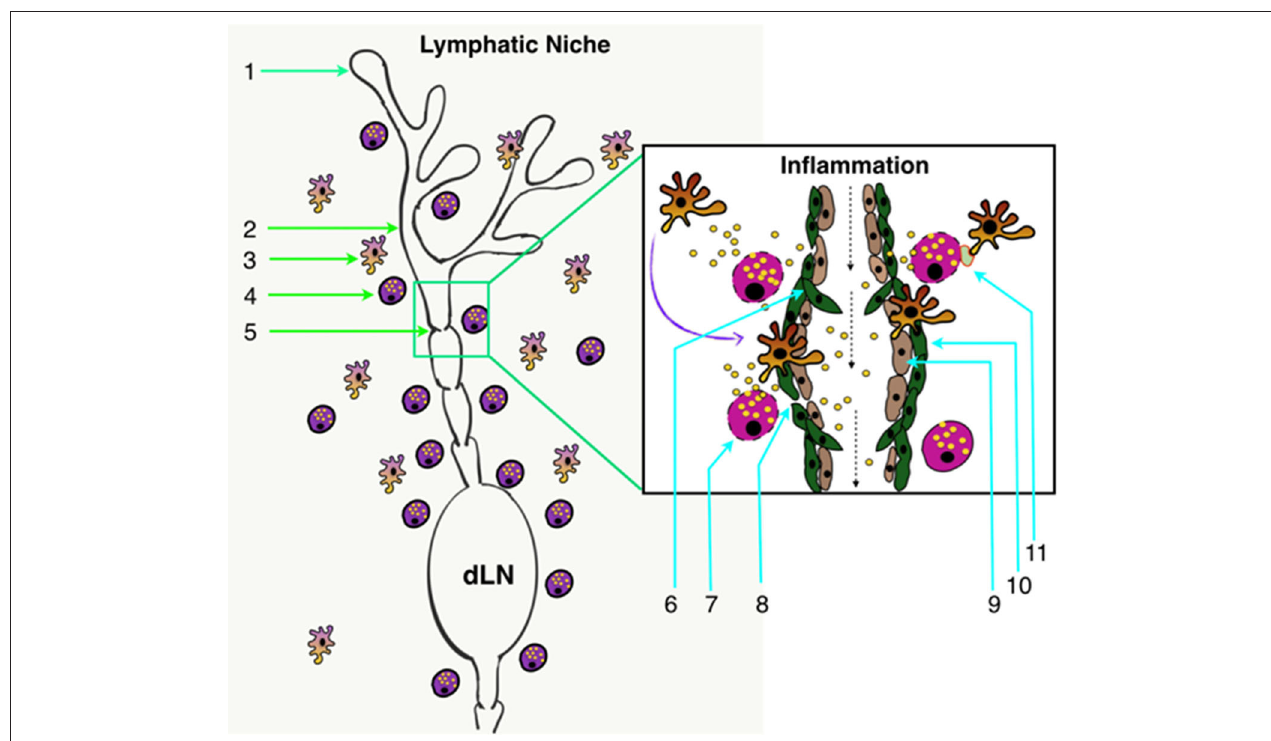
FIGURE 2 | Lymphatic system architecture along with the lymphatic tissue niche. (1) Initial lymphatics (lymphatic capillaries) (2) Pre-collector LVs; (3) Perilymphatic antigen-presenting cells; (4) Perilymphatic MCs; (5) Collecting LVs; (6) Lymphatic valve in collecting LVs; (7) Degranulating MCs in response to inflammation; (8) Increased permeability of LVs in response to inflammation; (9) LECs; (10) Lymphatic muscle cells; and (11) Inflammation-induced MC-DC immune synapse formation in perilymphatic tissues. dLN, Draining lymph